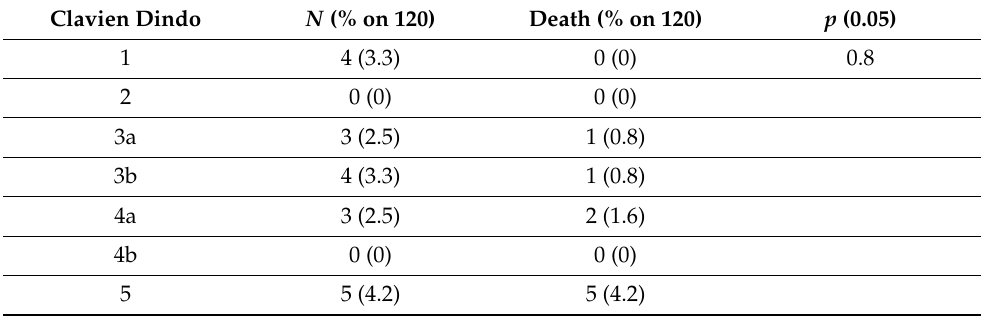
Table 5. Clavien Dindo Complications and their %, mortality and its %, and p (0.05). Clavien Dindo N (% on 120)